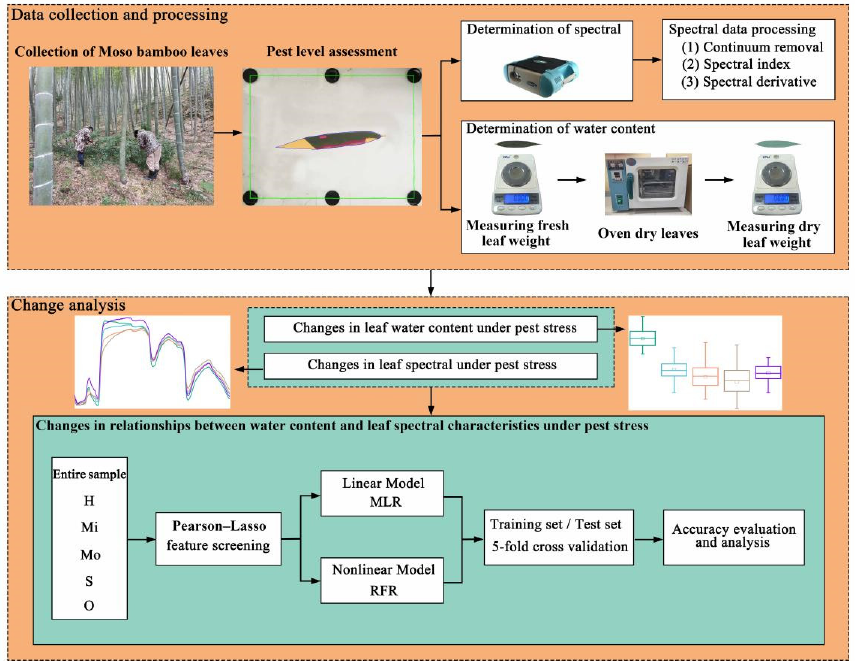
Figure 2. Workflow of changing relationships between water content and leaf spectral features in moso bamboo leaves under PPC stress.